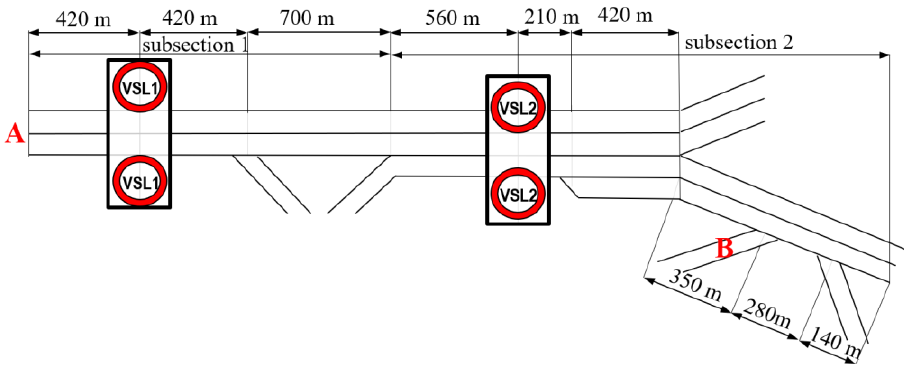
Figure 2. Test section with marked locations A and B of varying volumes among scenarios.